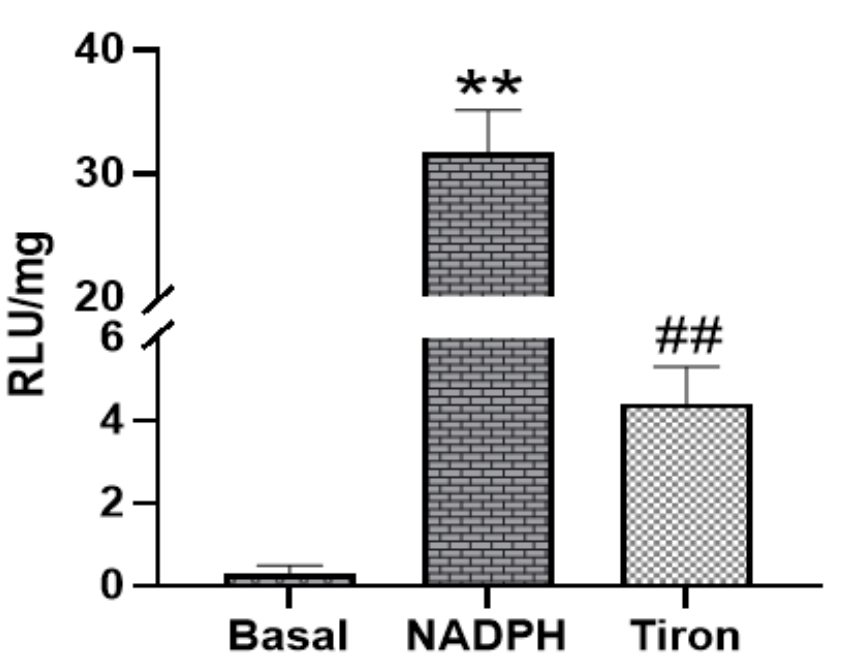
Figure 3. Superoxide production measured by lucigenin-enhanced luminescence in PAG tissue. Ad- dition of NADPH stimulated high levels of superoxide production; ** p < 0.01 vs. basal; ## p < 0.01 vs. NADPH, n = 21.